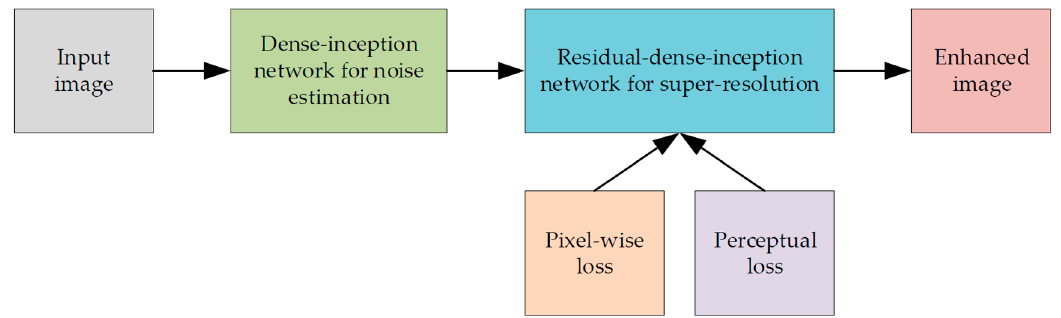
Figure 1. The framework of the proposed image quality enhancement method.